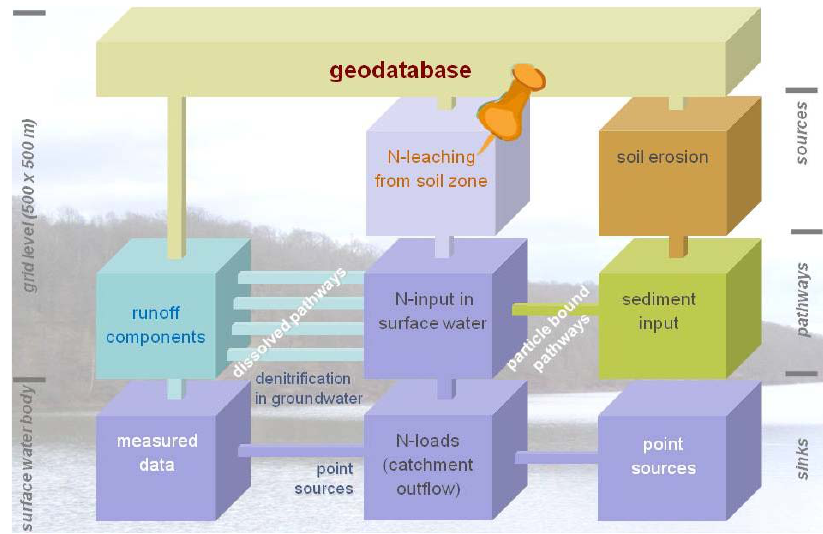
Fig. 1. Flowchart of the STOFFBILANZ.i modelling of diffuse